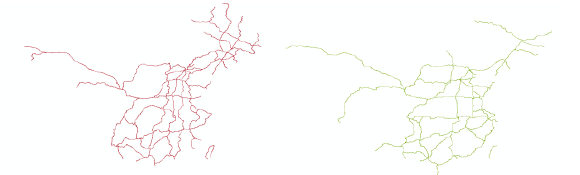
Figure 1. Counties with GDP per capita attribute in China Railroads and roads are the most significant means of ground transportation. This paper selects arterial railroads and roads with massive freight and passenger transportation in China(figure 2).